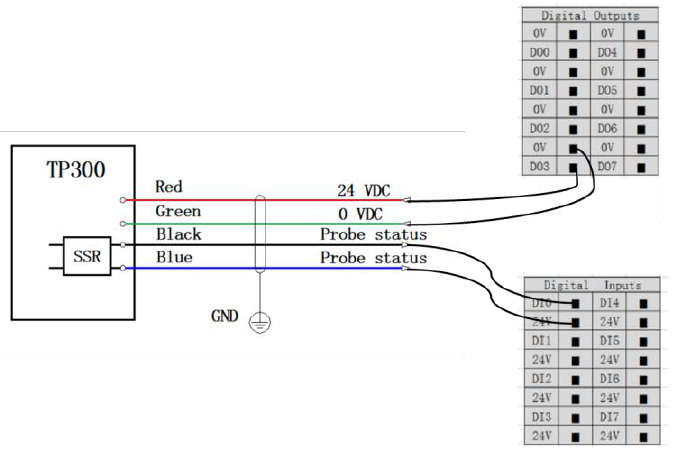
Figure 6. Electrical connection.